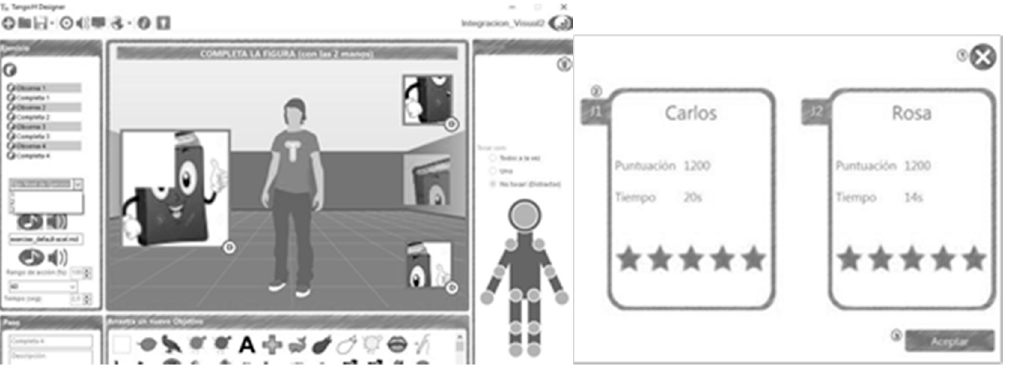
Figure 1. TANGO:H Designer and Game.